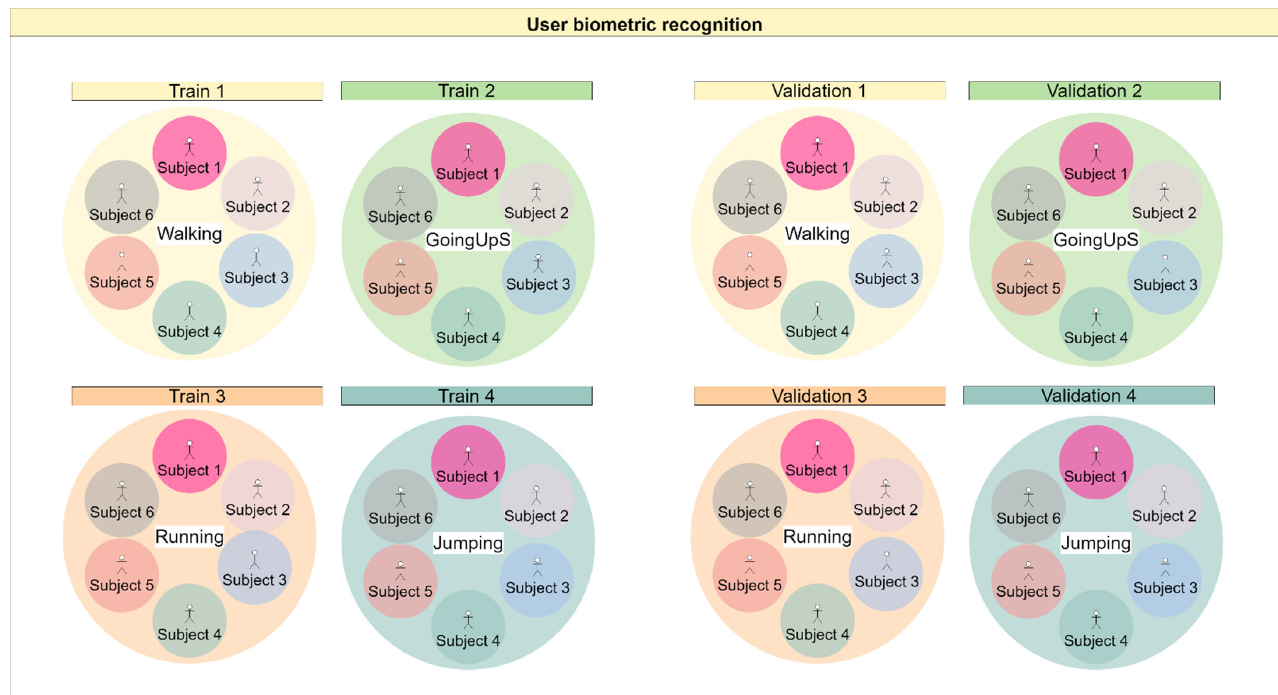
Figure 3. Division of the data for biometric user identification. The larger circles represent separate subsets, and the smaller ones represent different subjects. For example, the running activity is denoted by the orange circle and has a rectangle with the name Train 3 on the left side. There is the same orange circle on the right side, with the name Validation 3, meaning that we have a net trained to recognize individuals who have been trained and validated with just the running activity data.